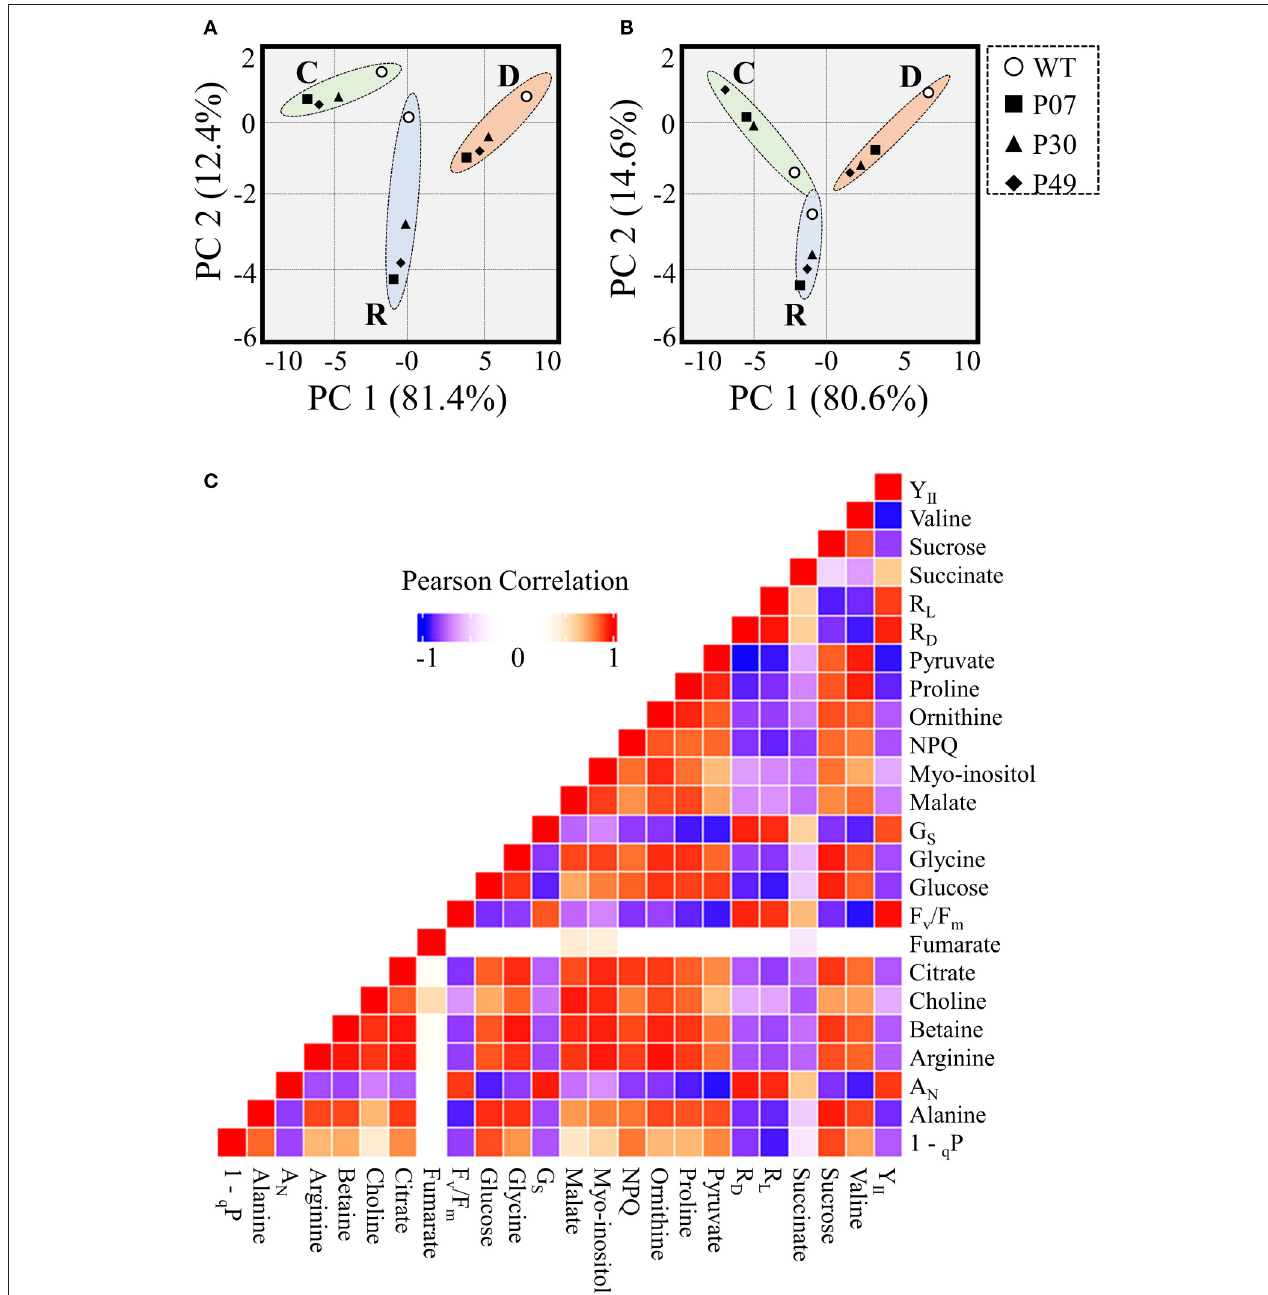
FIGURE 10 | Data integration of metabolomics combined with physiological parameters of WT and transgenic lines. Principle component analysis (PCA) scores plot representation of (A) metabolomics or (B) metabolomics combined with physiological parameters from WT and transgenic lines (P07, P30, and P49). Dashed lines represent 95% confidence intervals for well-watered (C), drought (D), and recovery (R) conditions. (C) Pearson correlation analysis of metabolomics combined with physiological